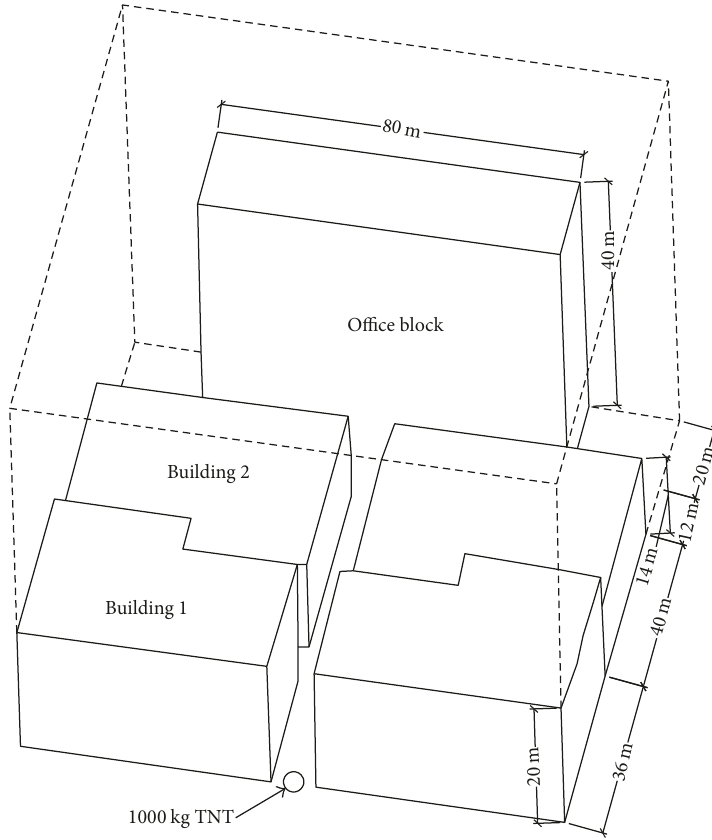
Figure 3: Detail of explosive placement, street, and target office block.